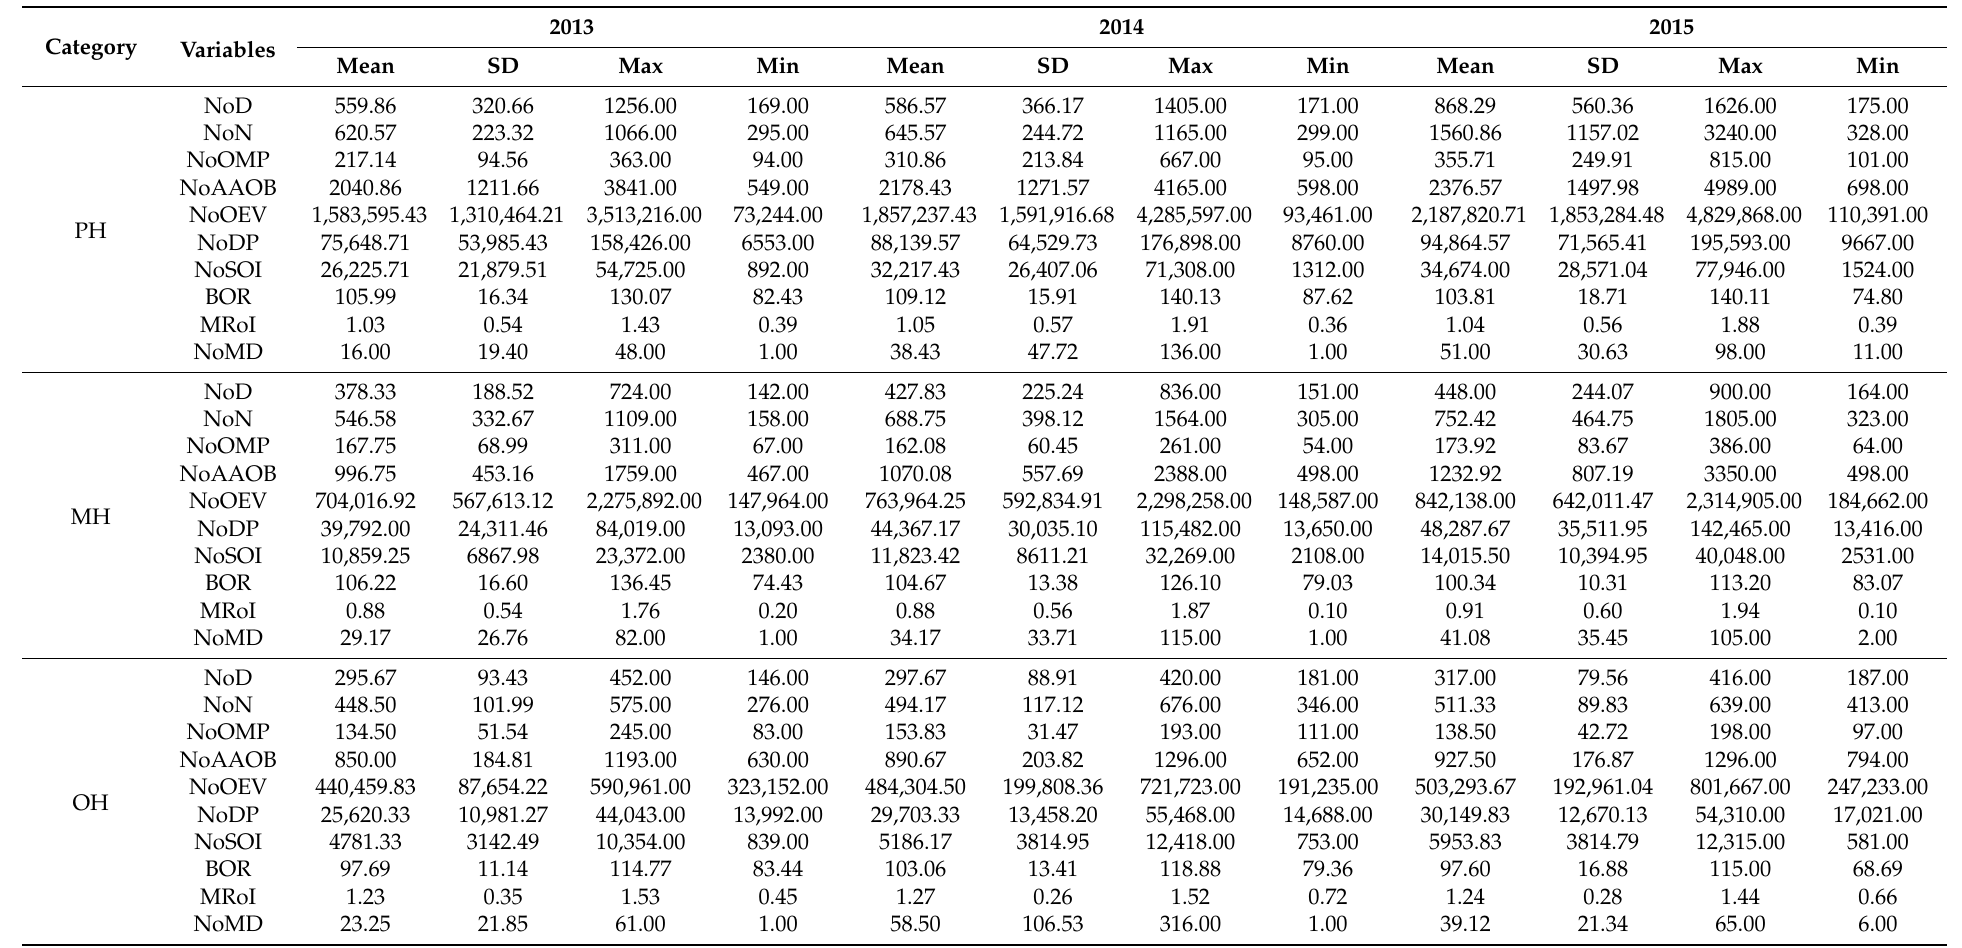
Table A1. Description statistics of input–output variables